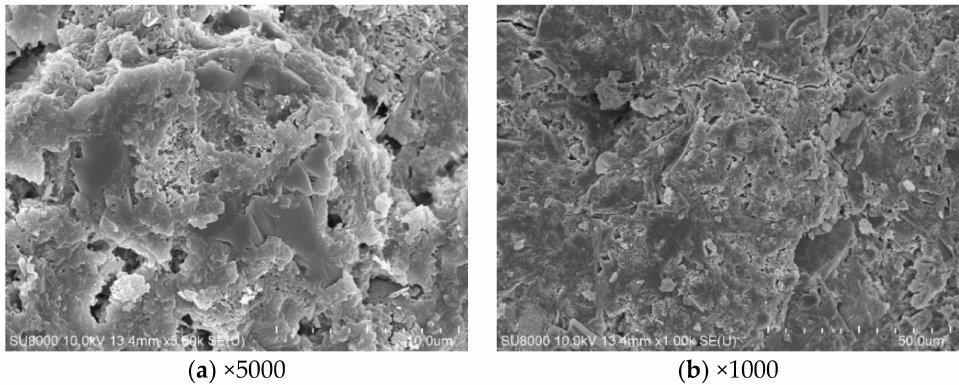
Figure 11. SEM images of 100% cement paste. ( a ) × 5000. ( b ) × 1000.